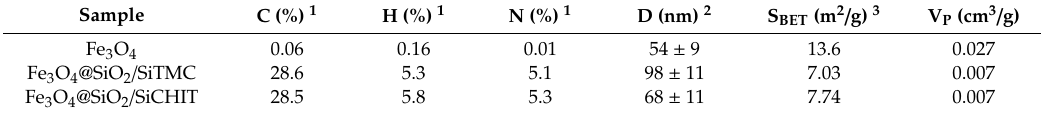
Table 1. Compositional and morphological properties of uncoated and coated Fe 3 O 4 nanoparticles. Sample